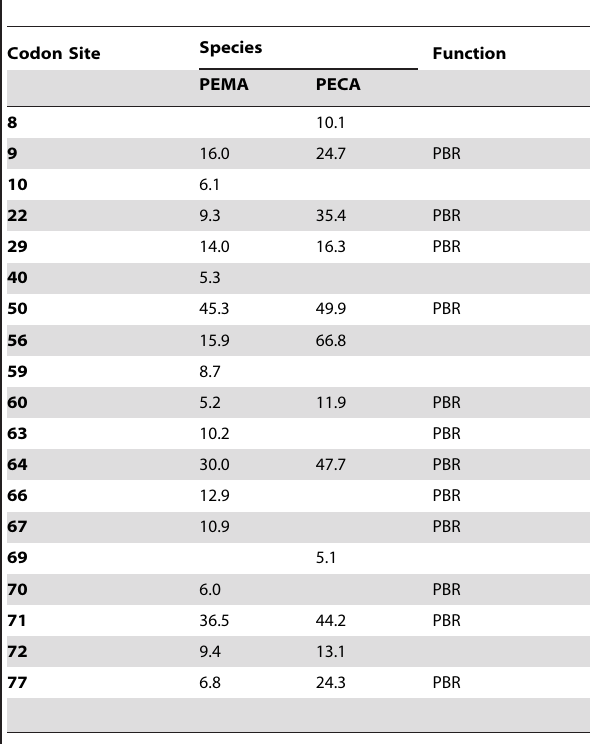
Table 2. Codons in exon 2 of the DQ a locus inferred to be under significant positive selection in each study